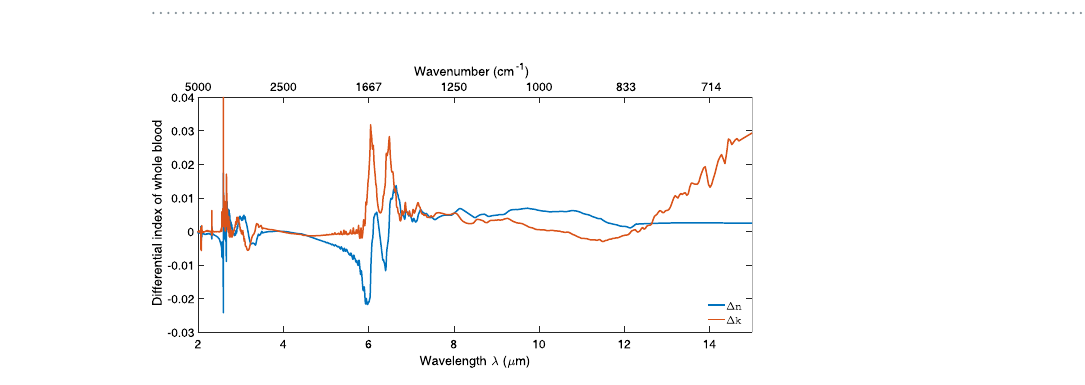
Figure 5. Real part of refractive index spectra n( λ ) for whole blood and aqueous solutions of paracetamol, aspirin, heparin, EDTA, PBS and CBC.